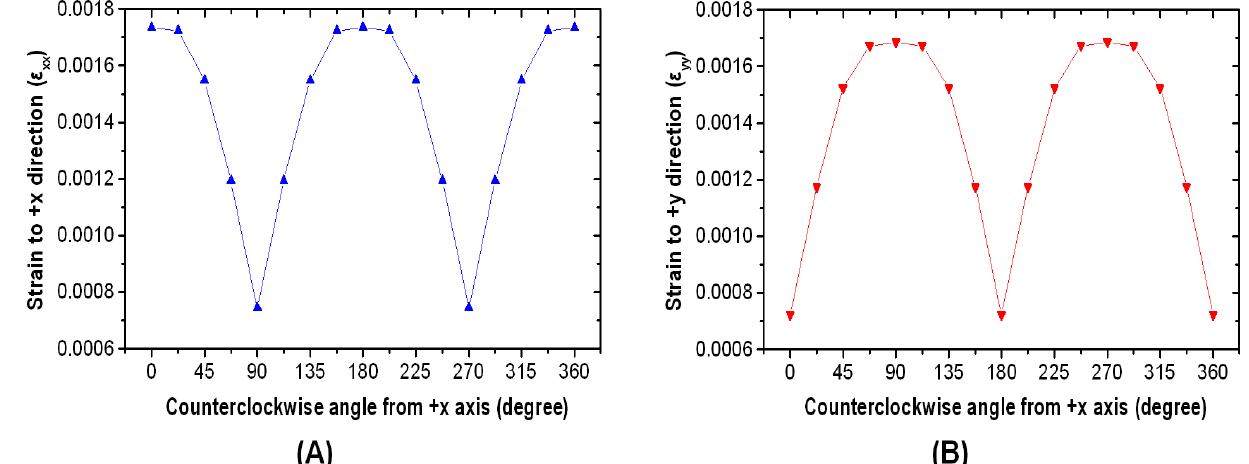
) and ( B ) principal strain variation in the + y xx